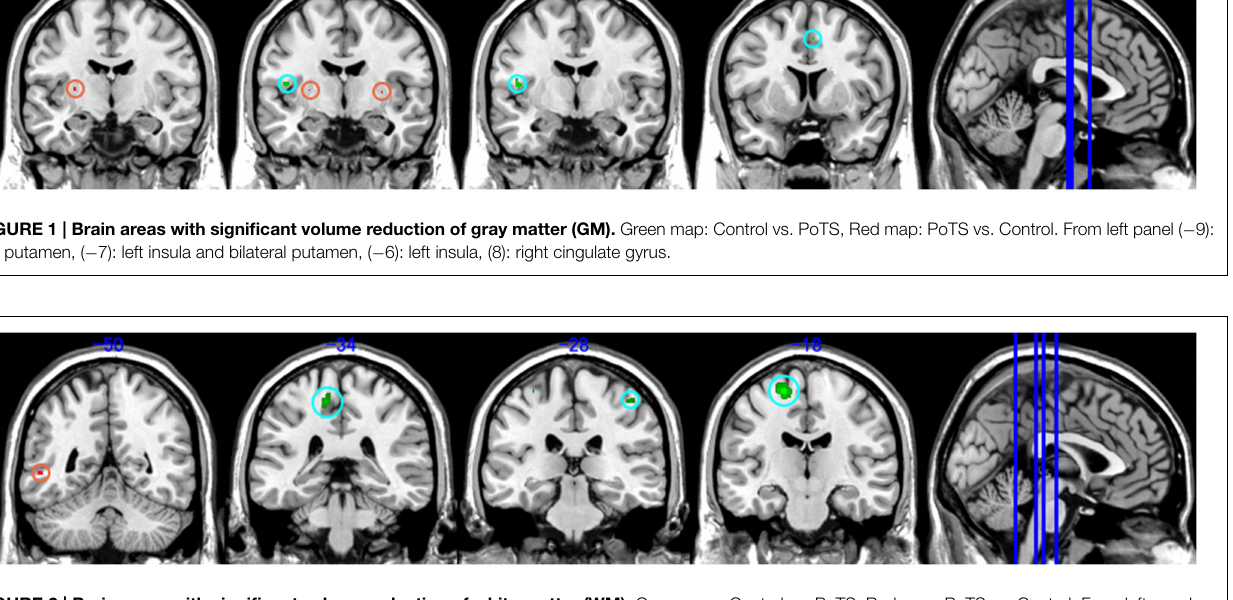
Frontiers in Neuroscience |